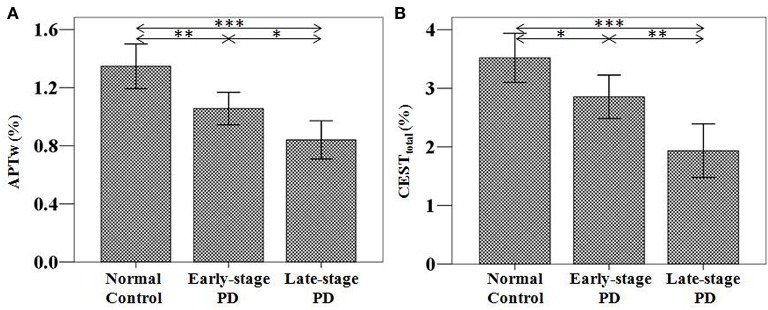
APTw (A) and CESTtotal
(B) values of the substantia nigra for normal controls (n = 24) and PD patients at different stages (grouped by disease duration) (n = 32 for early-stage and n = 29 for late-stage). The APTw and CESTtotal values of the substantia nigra for normal controls, early-stage, and late-stage PD patients were (1.35 ± 0.15) and (3.52 ± 0.42)%, (1.06 ± 0.11) and (2.85 ± 0.37)%, (0.84 ± 0.13) and (1.93 ± 0.46)%, respectively. Both showed a gradual decrease with disease progression. *P < 0.05; **P < 0.01; ***P < 0.001.